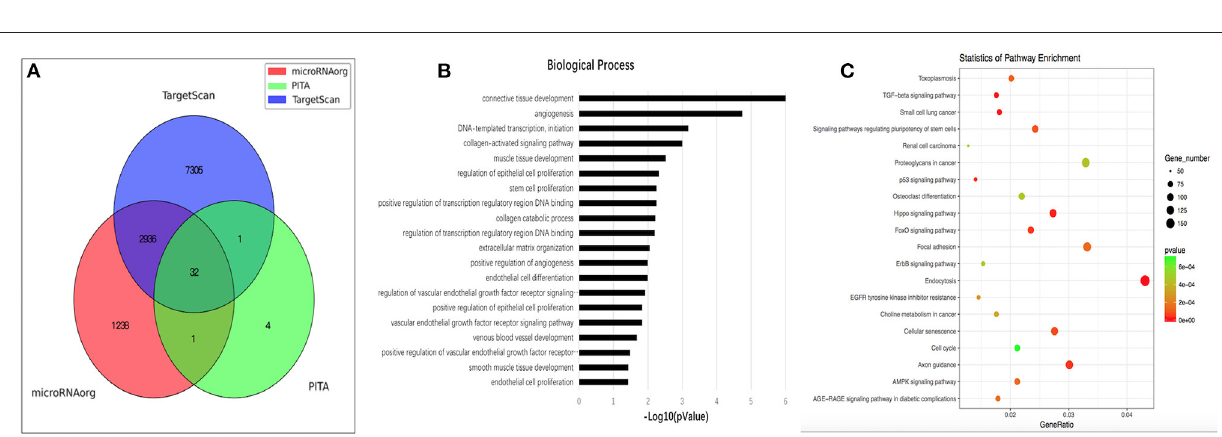
FIGURE 4 | Target genes and results of GO and KEGG analyses. (A) 3 targetsbase_venn. Venn diagram of target genes from three databases, TargetScan, PITA, and microRNAorg. (B) GO_barplot. Enrichment P -value histograms for each GO branch (sorted by P -value). (C) KEGG_dotplot. A bubble map for the result of KEGG branch enrichment (each KEGG branch is sorted by the P -value, taking the first 20 KEGG results). The abscissa is the ratio of the number of genes associated with the KEGG term in the target gene to the number of genes enriched in the KEGG database. The ordinate is the KEGG term. The color scale represents the P -value; when the color tends toward red, the P -value is smaller. The size of the circle indicates the number of differentially expressed genes in the pathway: the larger the point, the more significant in the gene. GO indicates gene ontology; KEGG, Kyoto Encyclopedia of Genes and Genomes; TGF, transforming growth factor and AMPK, AMP-activated protein